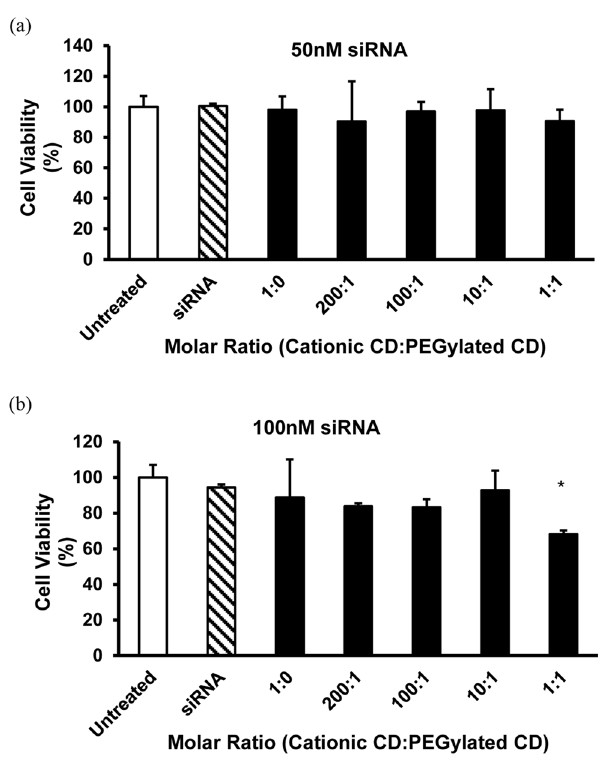
Figure 5. Neuronal viability after treatment with CDs. Viability of mHypoE N41 neuronal cells after treatment with CD.siRNA complexes (MR 20 cationic CD:siRNA) for 24 hours, with increasing content of PEGylated CD in the formulation, (a) 50 nM siRNA and (b) 100 nM siRNA. Cell viability was measured by means of MTT assay. Data are expressed as mean 6 SEM (n=3).